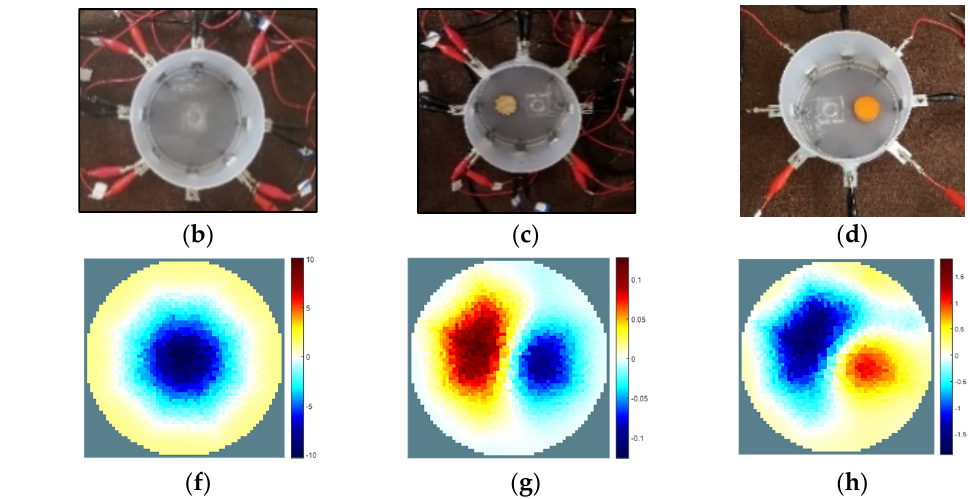
Figure 14. ( a ) Metal, ( b ) Plastic, ( c ) Metal + Plastic, and ( d ) Plastic + Carrot inhomogeneities at the centre of the EIT domain. The corresponding reconstructed images are presented at 5 kHz and 1 mA considering GHPF and the hyperparameter value ( λ ) of ( e ) 0.17, ( f ) 0.17, ( g ) 0.17, and ( h ) 0.017, respectively. The type of inhomogeneity from the mixed is identified successfully with the optimized hyperparameter value.